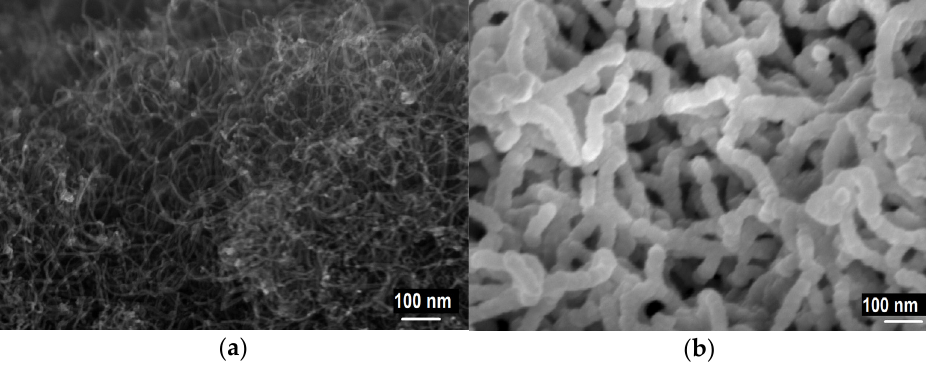
Figure 1. SEM observation of pristine CNT film ( a ) and of Si-CNT-ZnO-18 nm ( b ).